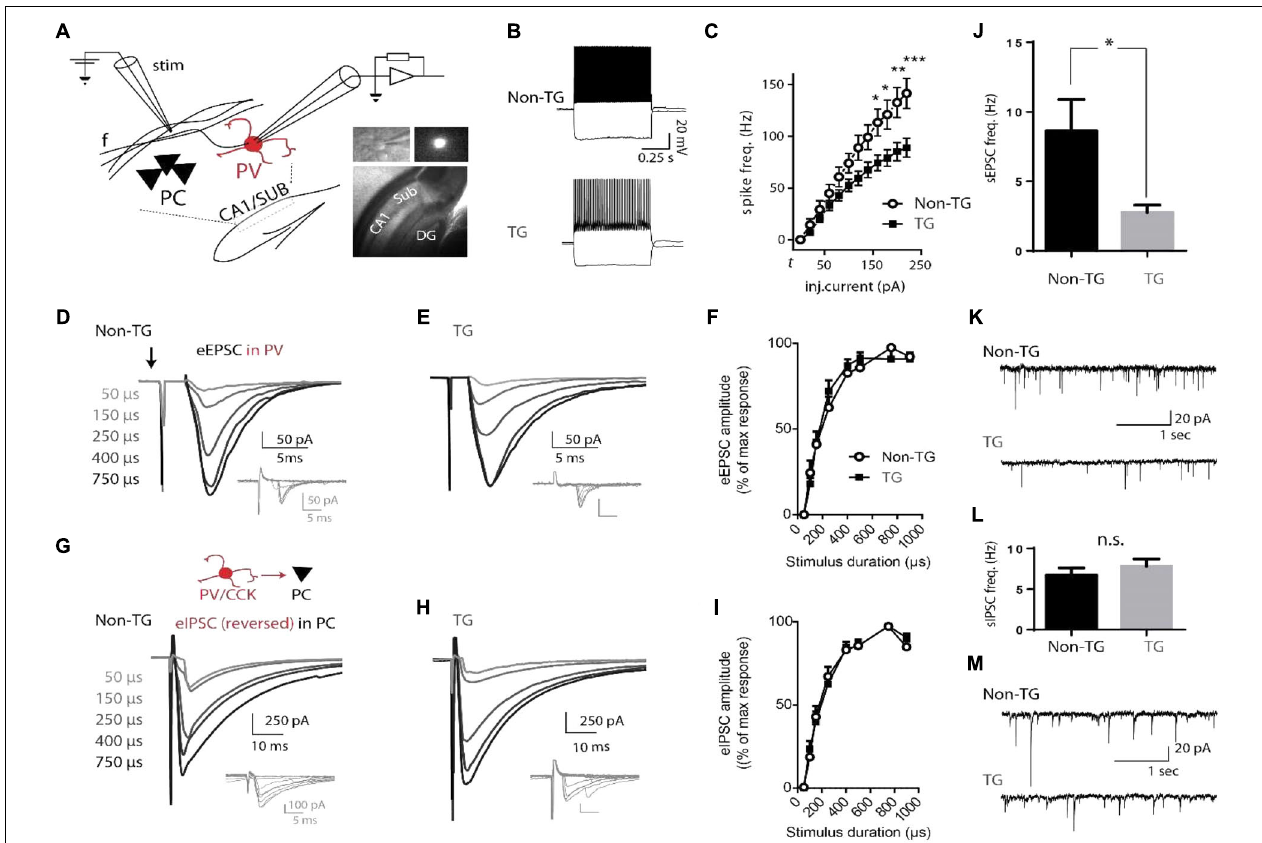
FIGURE 3 | Altered physiological properties of hippocampal PV interneurons in J20 mice. (A) Schematic drawing of the CA1/SUB region of a hippocampal slice showing the location of a recorded PV cell relative to a stimulation (Stim) electrode. Insert: representative images of a hippocampal slice and YFP-expressing fluorescent PV cell recorded in patch (40X). PC, pyramidal cell layer; f, CA1-subiculum fibers; DG, dentate gyrus. (B) Fast-spiking (FS) firing-pattern evoked in PV neurons from Non-TG and TG J20-PV-Cre animals (top and bottom, respectively) in response to depolarizing current steps. Hyperpolarizing steps essentially show absence of voltage-dependent inward rectification (depolarizing sag) and associated rebound firing. (C) Plot of mean firing frequencies in response to injected currents of various supra-threshold amplitudes in PV interneurons from Non-TG (open circles) and TG mice (solid squares). Current injections were 600 ms square pulses. Firing-frequencies are plotted from threshold current ( t ) to t + 200 pA. Note that PV cells from both groups show typical fast-spiking (FS) properties but that a significant group-specific difference in firing frequency is evident at current injection levels shown. (D,E) Representative examples of CA1 evoked excitatory post-synaptic currents (eEPSCs) recorded in PV cells from non-TG and TG mice. Each trace (average of 5–10 trials) was evoked by increasing the duration of the minimal current pulse, from threshold to maximum (50–900 µ s), without changing the stimulus amplitude. Insets (gray traces below) show successive responses to minimal stimulation (with 5/10 failures in D and 4/10 failures in E ). Extracellular electrical stimuli were delivered at low-frequency (0.33 Hz) through a glass pipette placed 100–200 µ m from the soma of the recorded PV cell (in the stratum pyramidale/oriens, toward the CA1/sub border). Stimulus artifact is indicated by the arrow pointing down. Evoked EPSCs increased monotonically with stimulus duration until saturation at ∼ 400 µ s. (F) Plot of mean eEPSC amplitude in response to stimuli of increasing duration for PV cells from Non-TG versus TG groups. The EPSC evoked at each stimulus duration was normalized to the maximal response of each neuron. Overall a two-way ANOVA indicated that the amplitude of CA1-projection evoked excitatory post-synaptic currents (eEPSCs) did not differ between Non-TG and TG mice. G and H , evoked inhibitory post-synaptic currents (eIPSCs) recorded in pyramidal neurons (average of 10 trials per trace) during activation of local inhibitory cells at various stimulation intensities in non-TG and TG mice. Insets (gray traces) show responses to minimal stimulation (4/10 failures in G ; 6/10 failures in H ). (I) Mean normalized amplitude of eIPSCs elicited in pyramidal neurons by electrical stimuli in local GABAergic cells. (J,K) mean frequency of spontaneous EPSCs (bar graph) recorded from PV cells in non-TG and TG mice and representative example. (L,M) same as J and K for spontaneous IPSCs recorded from PCs in non-TG and TG mice ( n = 10, non-TG and 8,